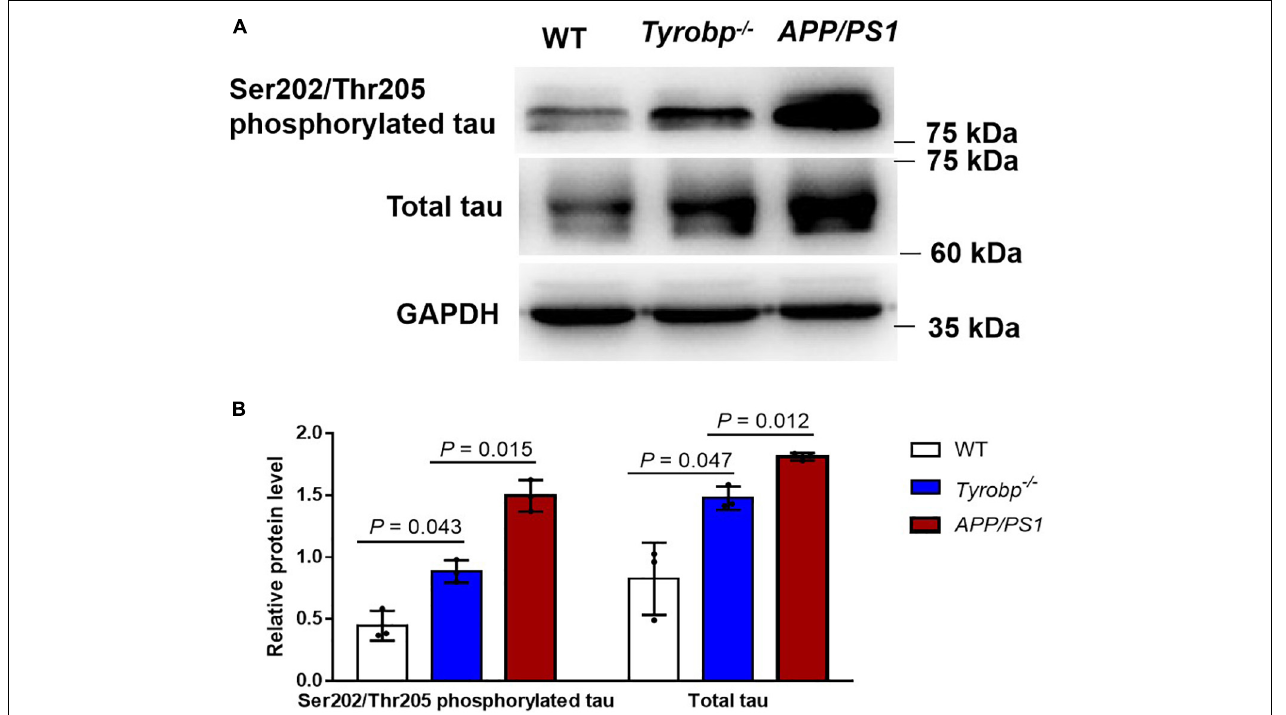
FIGURE 4 | Levels of total tau and Ser202/Thr205-phosphorylated tau in WT, Tyrobp − / − and APP/PS1 mice. (A) Western blot analysis. (B) Quantification of total tau and Ser202/Thr205-phosphorylated tau. Data are mean ± SEM from three independent experiments (three mice per group). Differences were assessed for significance using Student’s t test.